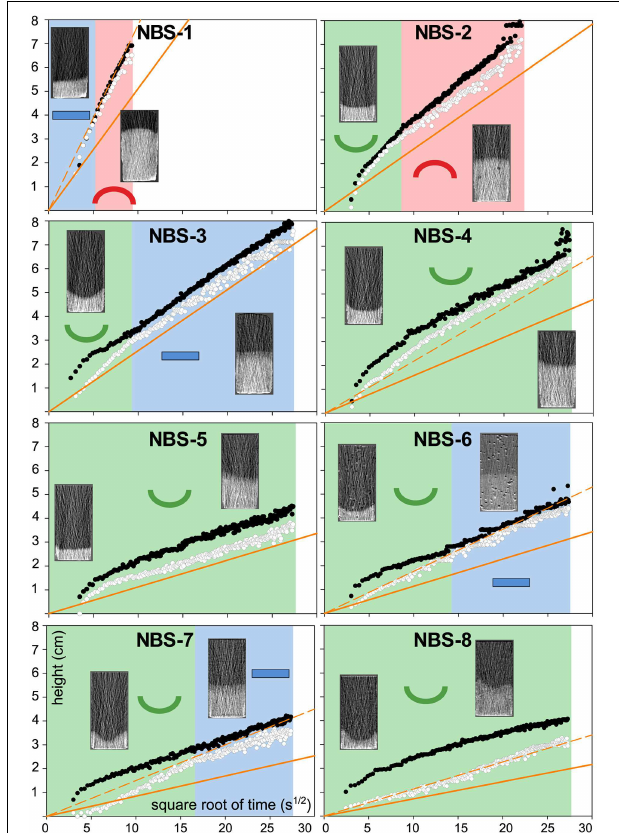
FIGURE 3 | Heights evolution of the water front as a function of square root of time. Solid and open circles correspond to the maximum and minimum heights, respectively. The shape of the front (upward/downward concave, flat) is represented with different symbols and background colors (respectively green, red, and blue). The solid and dashed lines correspond to the prediction from capillarity coefficient C using the final saturation and an ad hoc saturation